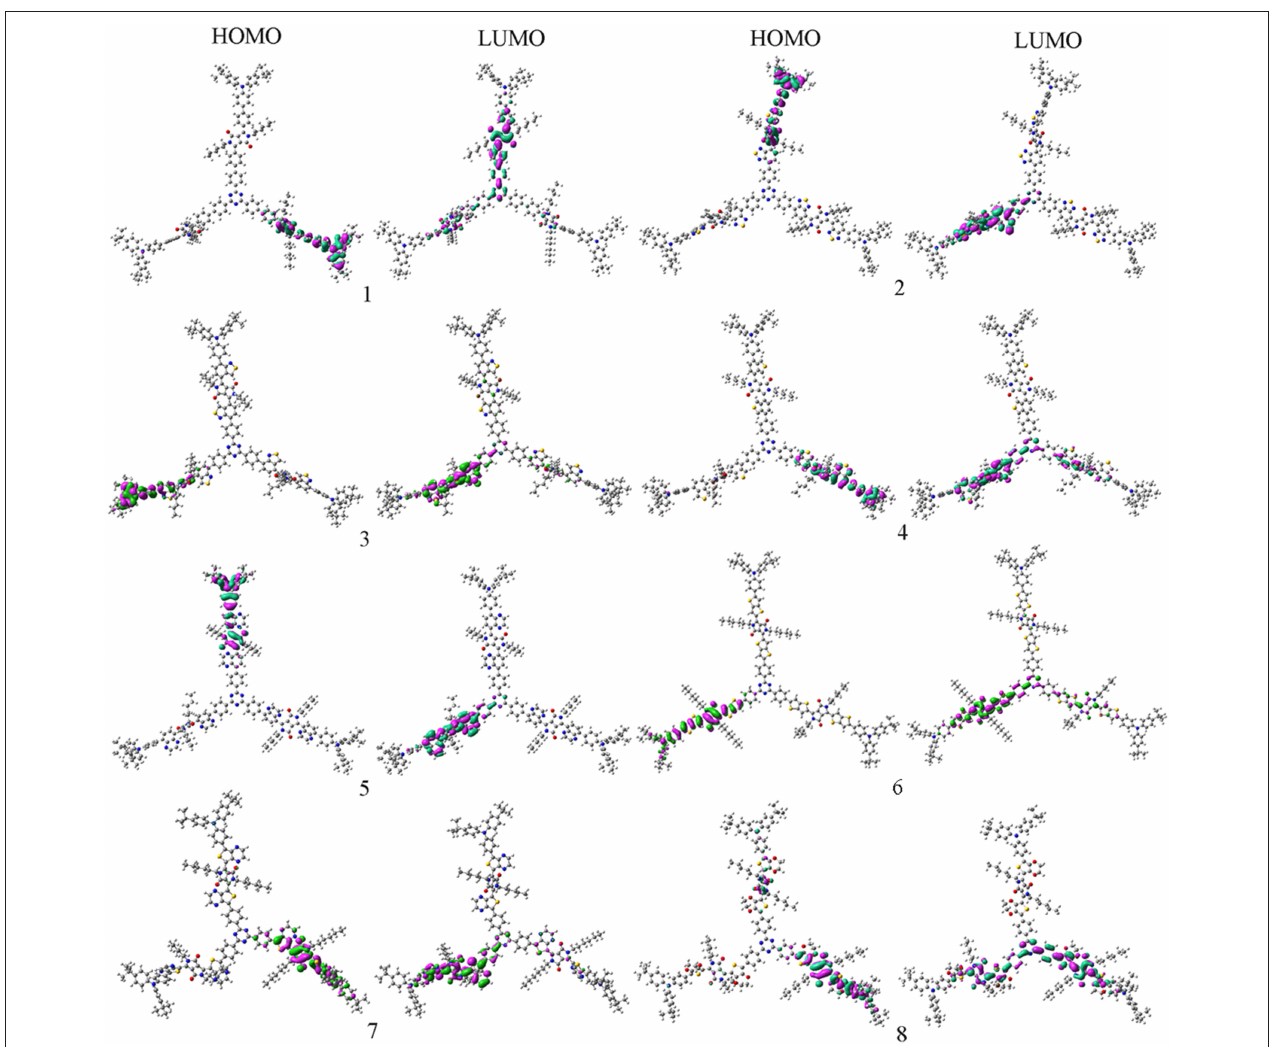
FIGURE 2 | The FMOs of the designed molecules at the PBE0/6-31G(d,p)